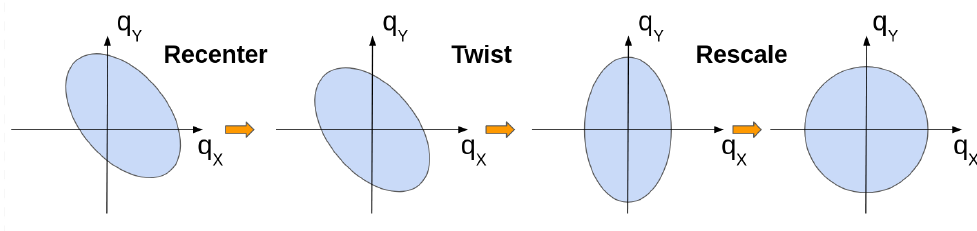
Figure 4. Schematic illustration of recenter, twist and rescale correction